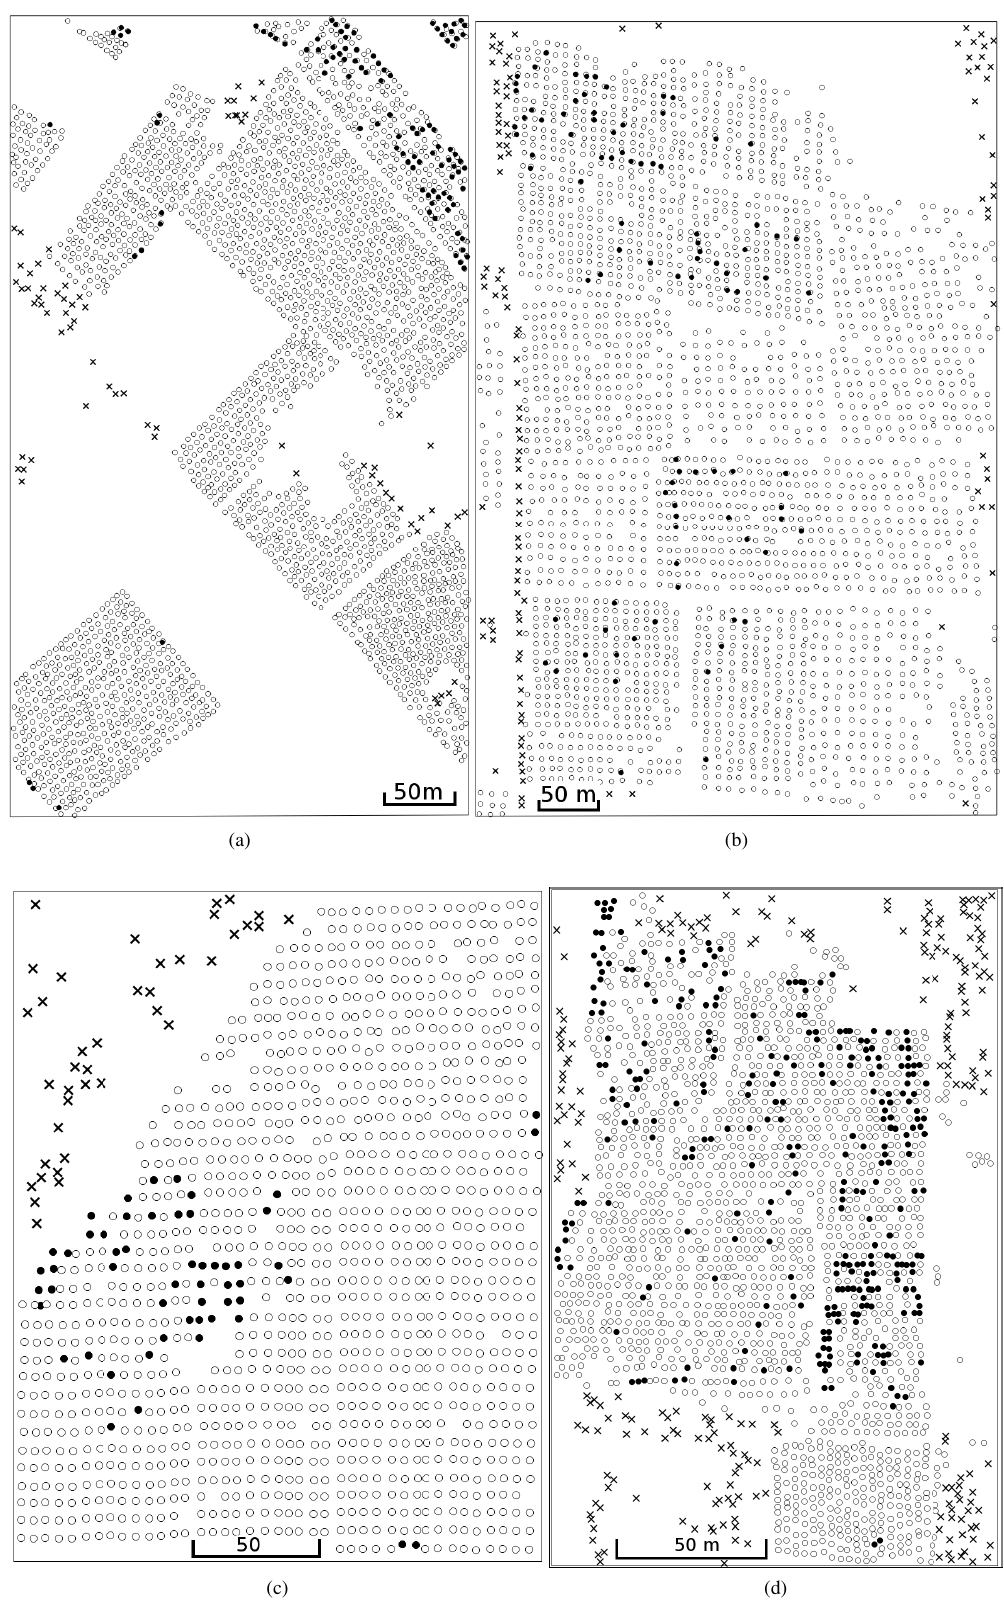
Figure 3: Mapping of the tree counting results for the four test images (a) Grenoble, b) Juazeiro, c) Citrus Grove, d) Southington): empty circles ( ◦ ) represent trees that were found, “ × ”s represents the false negatives and the black circles ( • ) represent the false